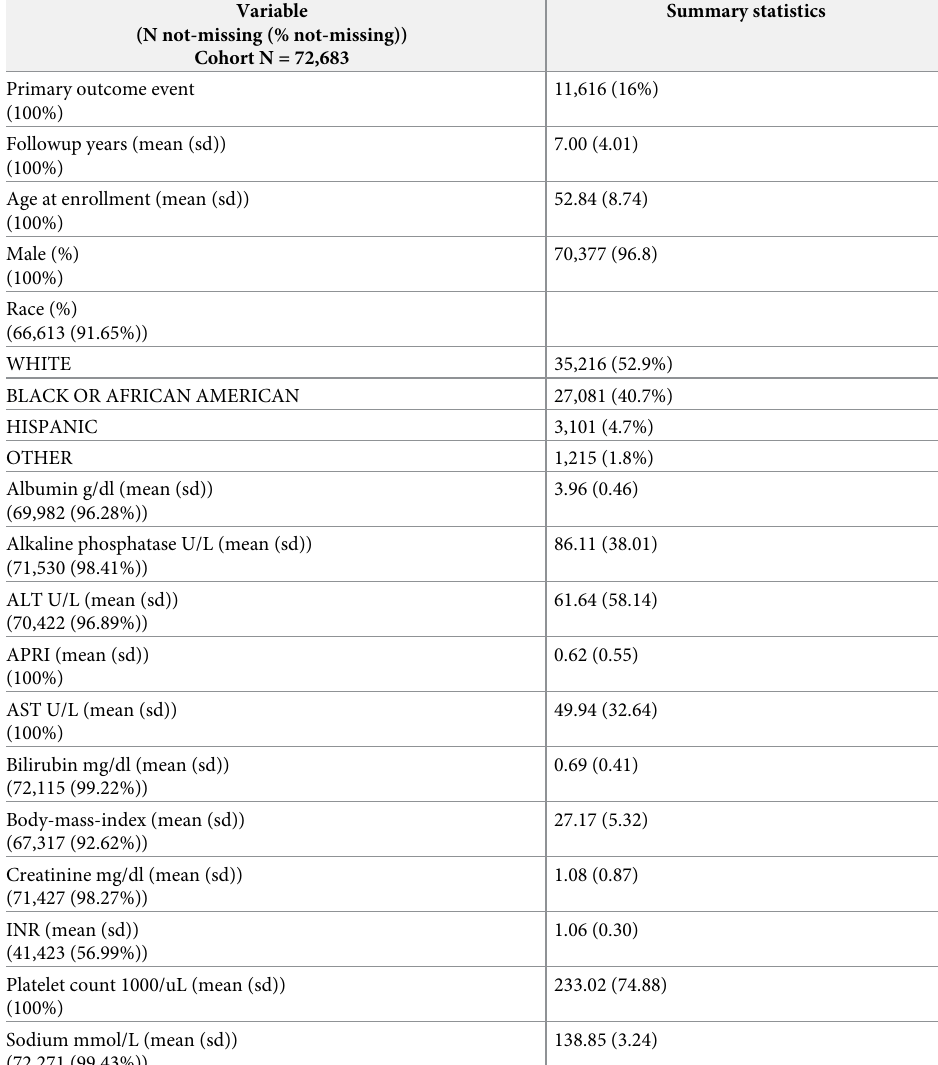
Table 1. Baseline characteristics. Variable (N not-missing (%